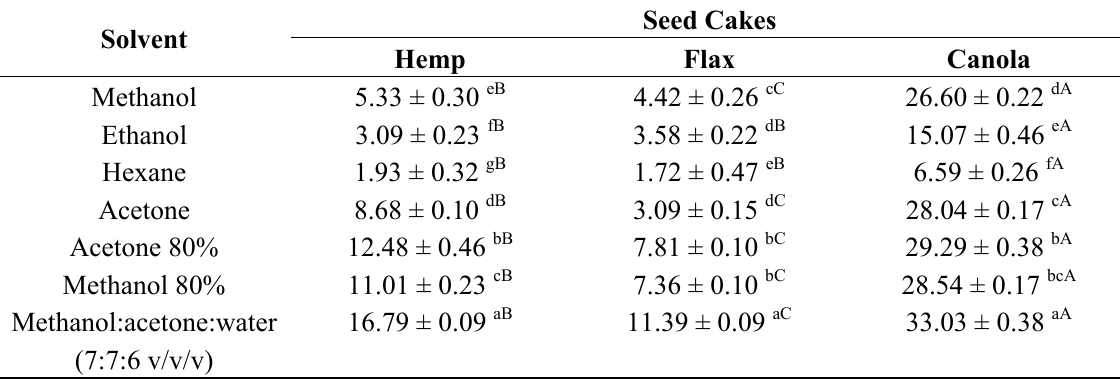
Table 3. DPPH free radical-scavenging assay (% inhibition of DPPH • ).